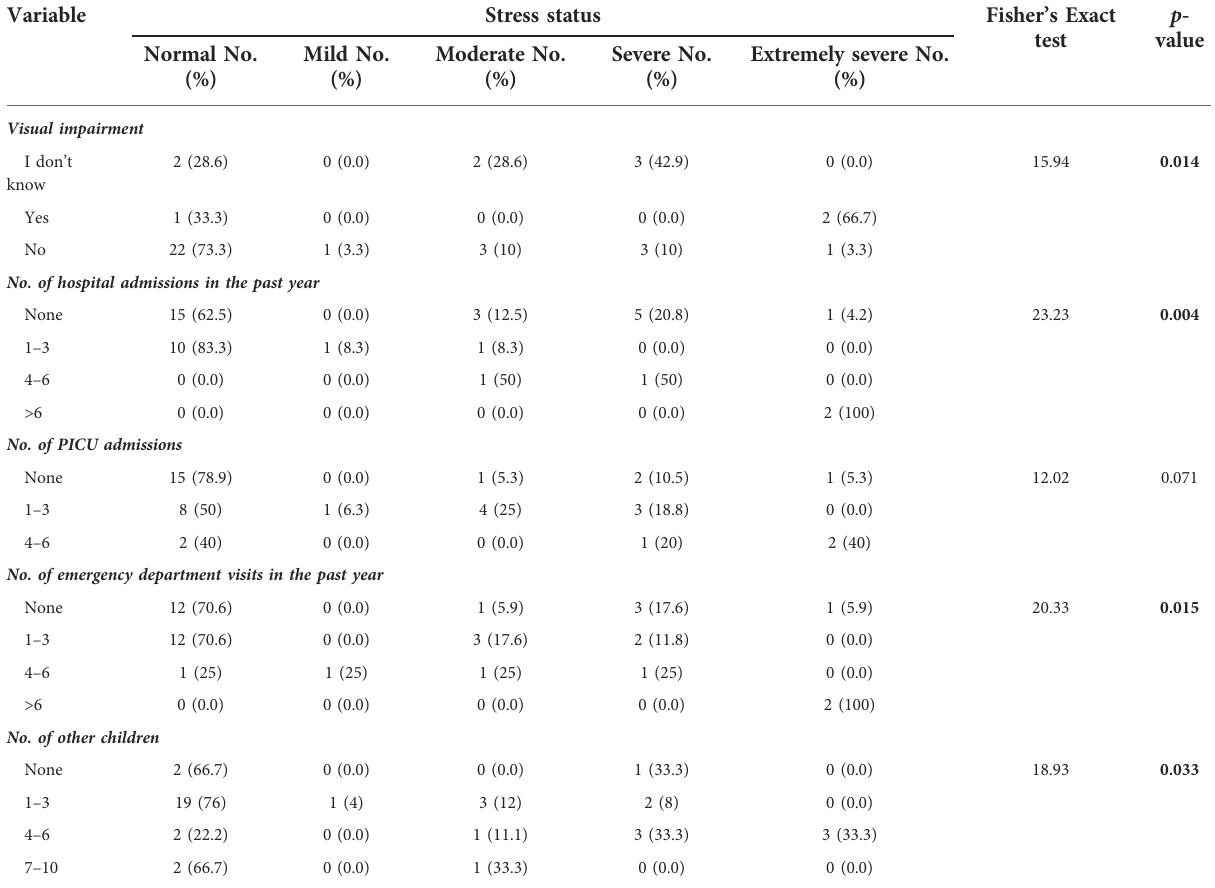
TABLE 5 Relationship between stress status and child health status.